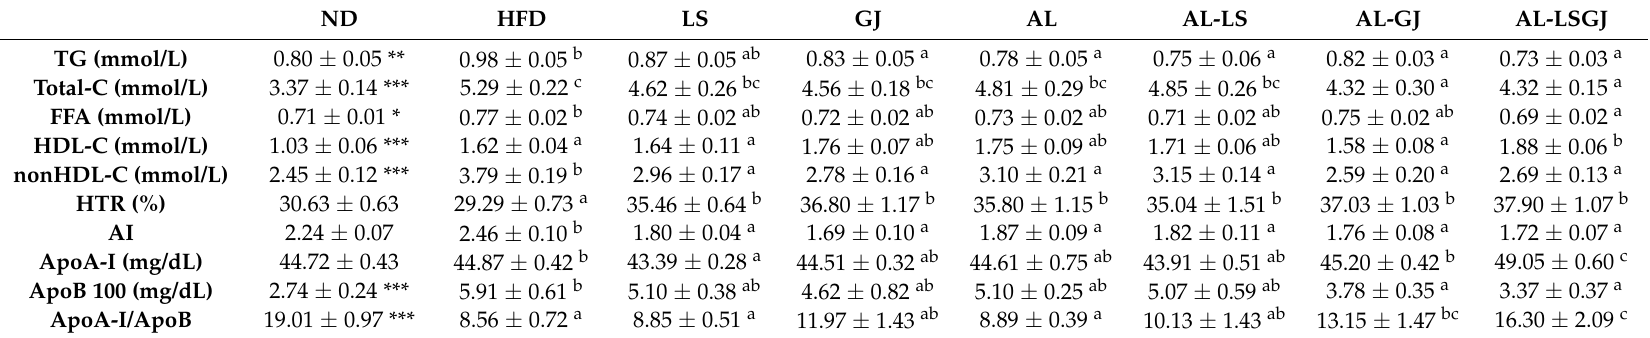
Table 4. Effect of synbiotic supplementation for 12 weeks on plasma lipid profiles in diet-induced obese